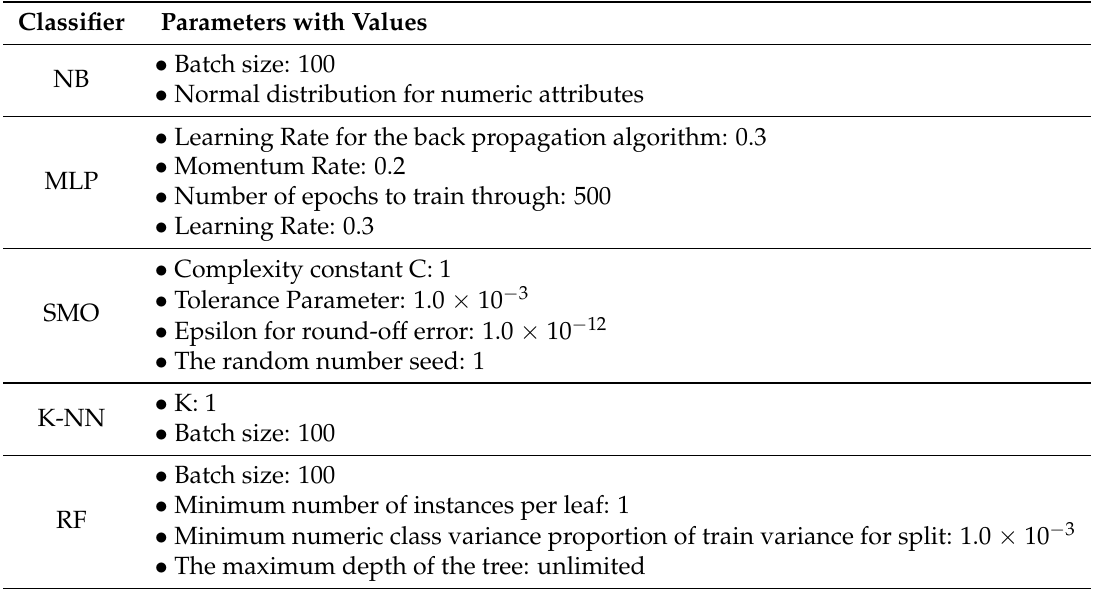
Table 1. Detail values of the parameters used by the classifiers under